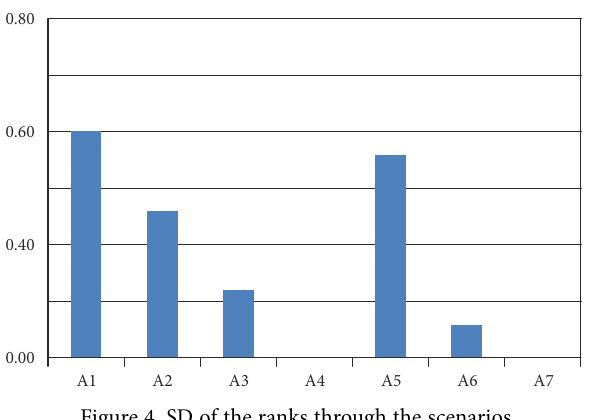
Figure 4. SD of the ranks through the scenarios